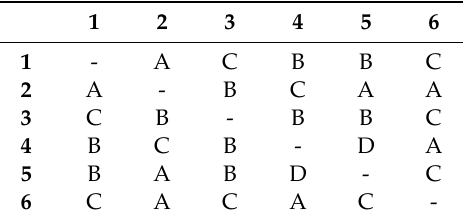
Table 2. Road type from farm to farm.